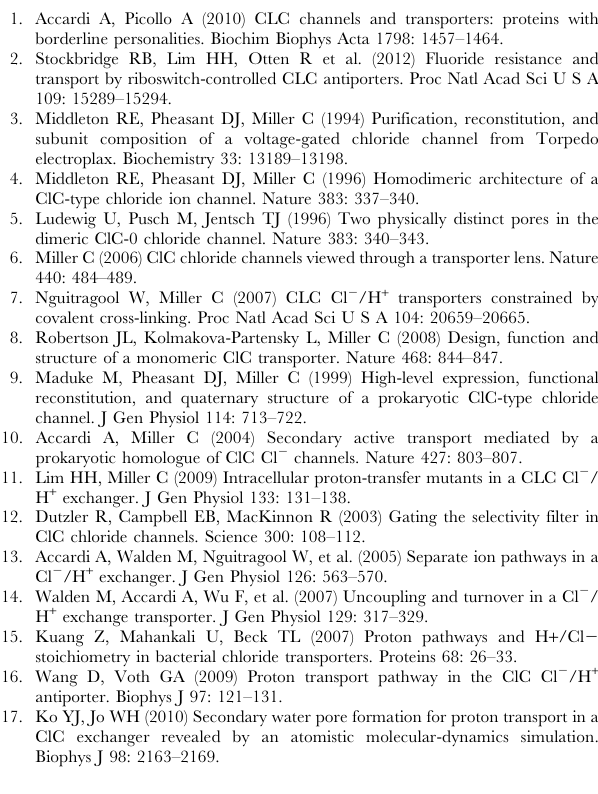
Table S1 Data collection and refinement statistics of D NC and Table S2 Cl 2 /H + transport metrics. Table S3 Thermodynamic parameters for Cl 2